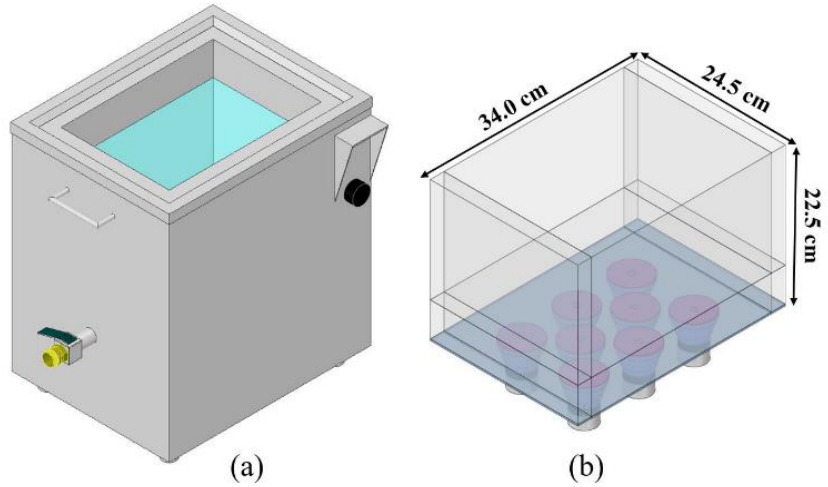
Figure 2. A conventional ultrasonic cleaning tank (UCT): ( a ) CAD model and ( b ) simplified